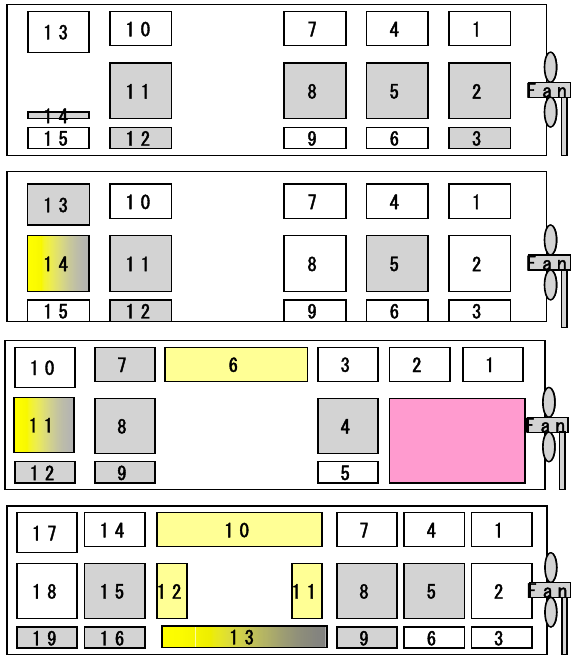
Figure 19. Mass flow rates of the original and modified CBMs. Table 3. Mass flow rate (kg / s) of the original and modified cover back machine (CBM). Outlet. Existing Model Model 1 Model